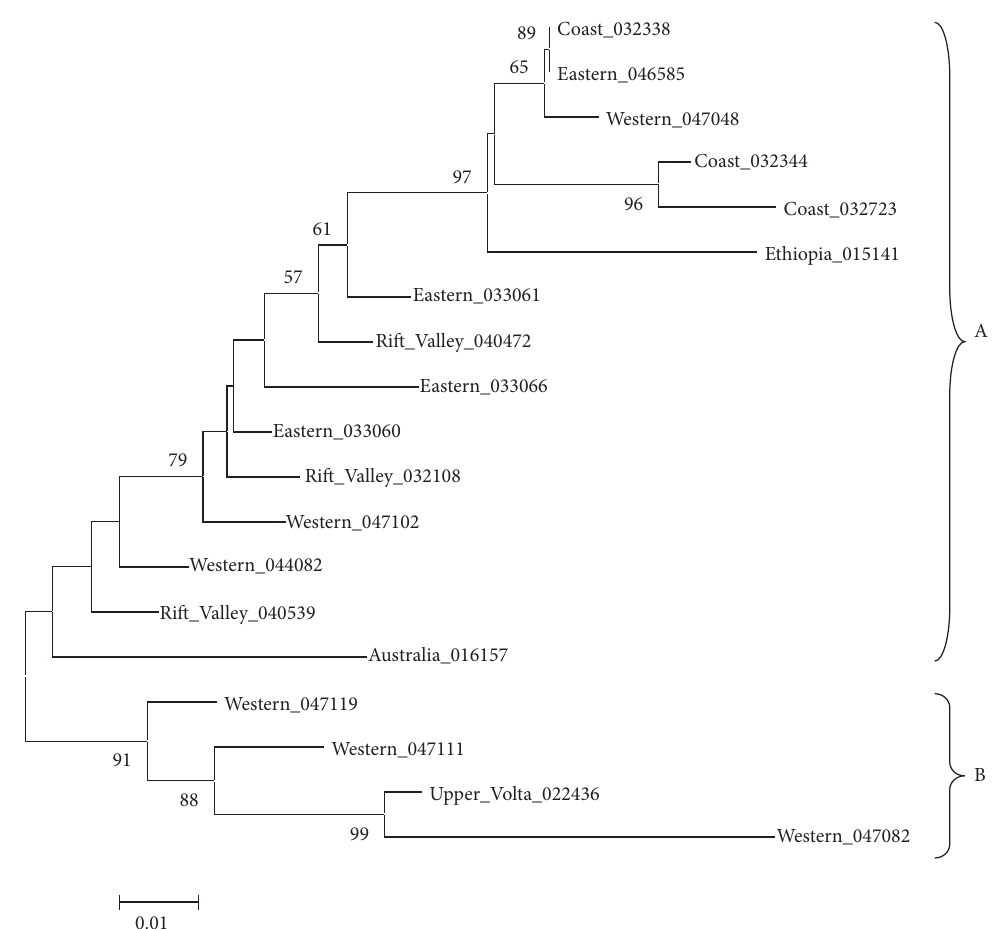
Figure 2: Phylogenetic tree of cowpea varieties: varieties having similar distances are genetically